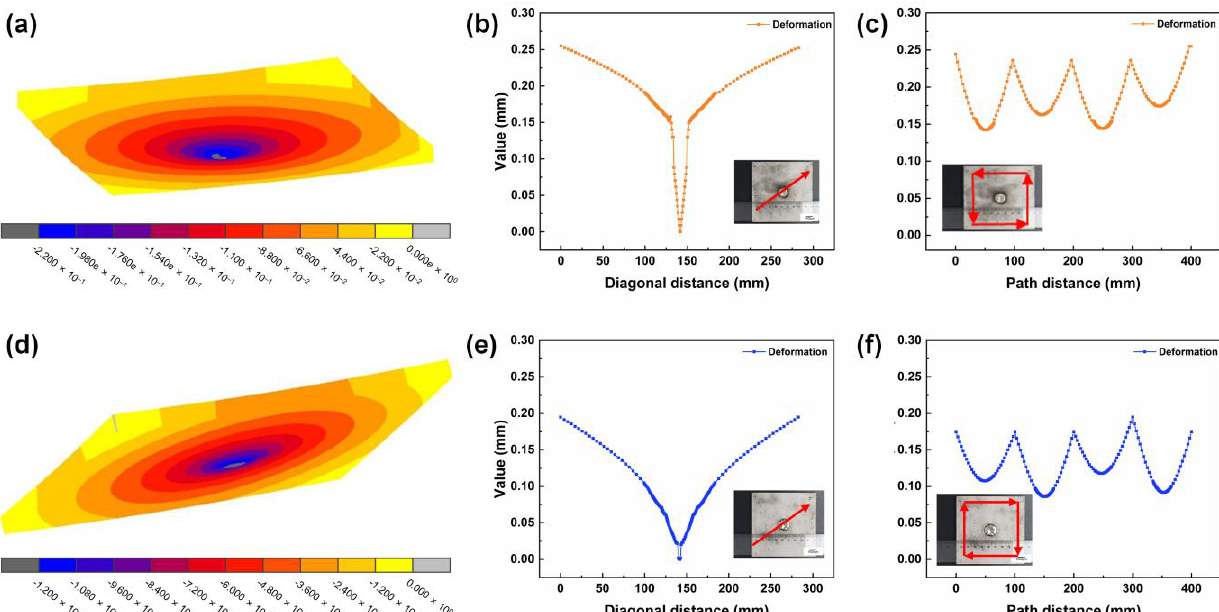
Figure 13. Deflect deformation for the samples with different repaired layers: ( a – c ) Deflect deformation contour, deflect deformation along diagonal, deflect deformation along edge distribution under 1.0 mm focus laser diameter, ( d – f ) Deflect deformation contour, deflect deformation along diagonal, deflect deformation along edge distribution under 2.5 mm focus laser diameter.